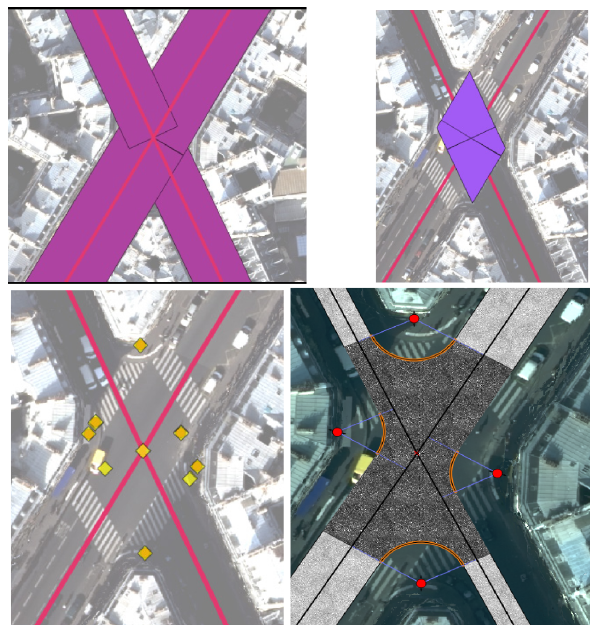
Figure 6: The method to robustly find circle centres.